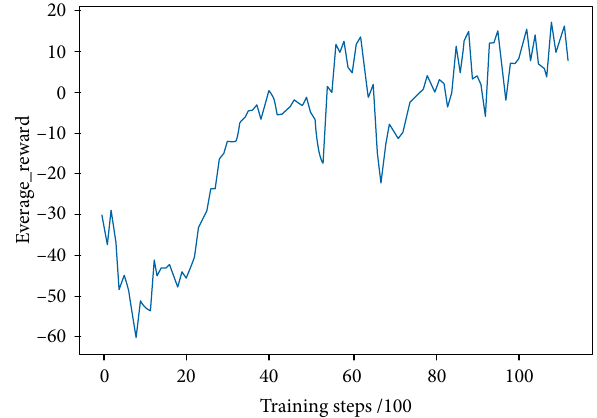
Figure 9: The average cumulative reward curve. Each point is the average cumulative reward achieved per hundred episodes. The y-axis denotes the average cumulative reward and x-axis denotes iteration